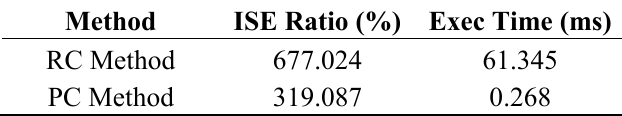
Table 1. Comparative evaluation of Integral of Squared Error (ISE) ratios and CPU Execution